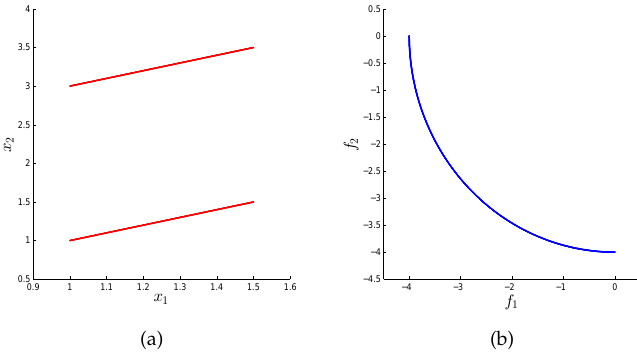
Figure 1. ( a ) Pareto set and ( b ) Pareto front of a hypothetical bi-objective problem where the Pareto set consists of two connected components that both map to the entire Pareto